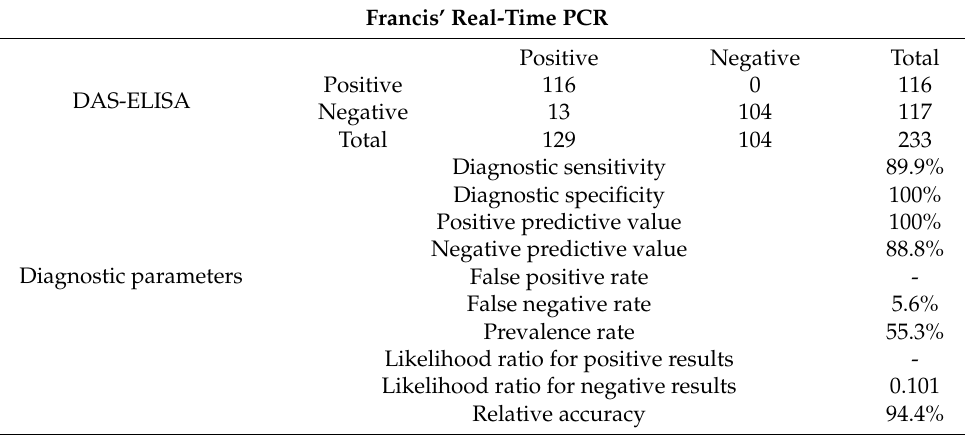
Table 5. Contingency table comparing mAb2G1/PPD DAS ELISA with real-time PCR Francis et al. [32] for Xylella fastidiosa detection in samples of naturally infected and healthy plants. The upper part shows the positive and negative results for each technique. The diagnostic parameters corresponding to these results are shown in the lower part.